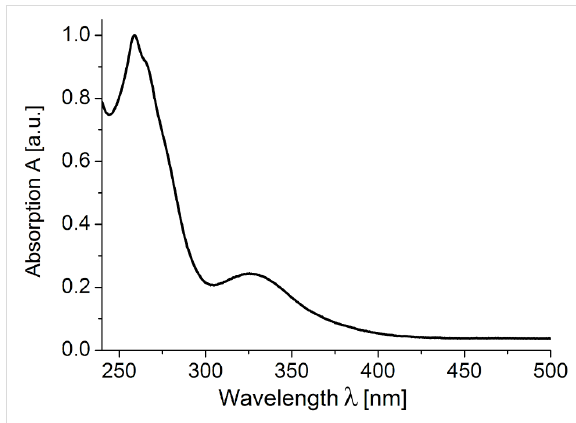
Figure 5: Normalized absorption spectra of the phenothiazine–anthraquinone dyad 8c (recorded in CH 2 Cl 2 , c ( 8c ) = 2.5 ∙ 10 − 5 mol·L − 1 , T = 298 K).